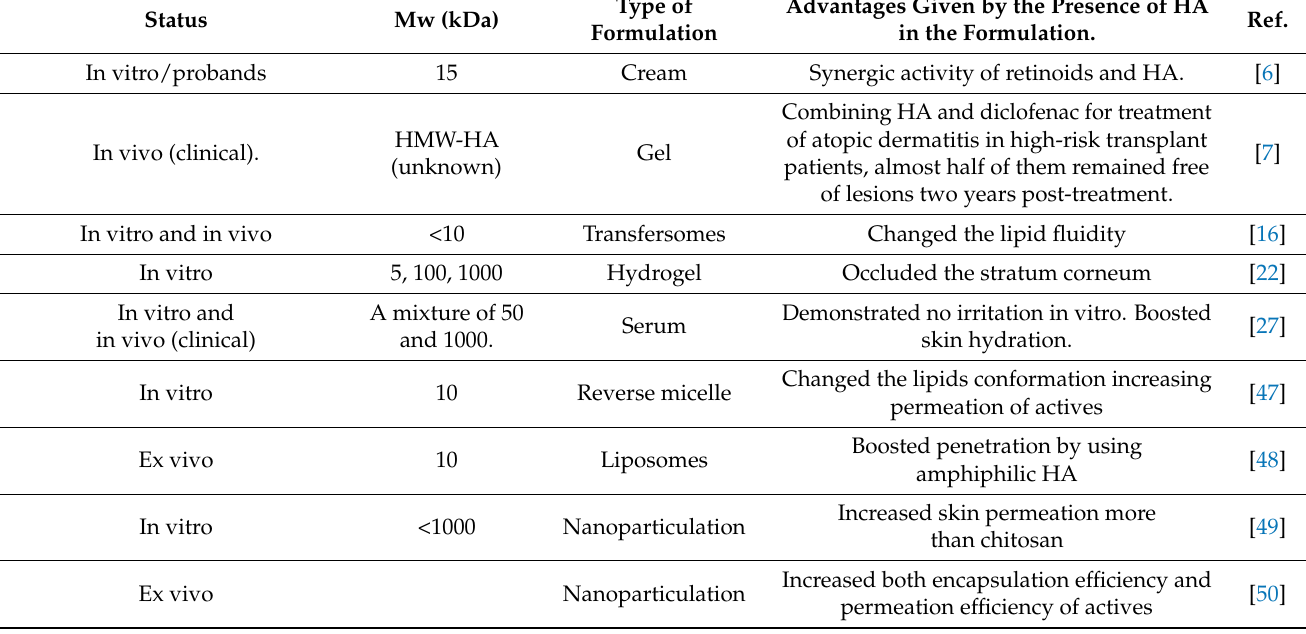
Table 1. Selected examples describing biological properties after the incorporation of HA in a formulation describing in vitro, in vivo, and clinical